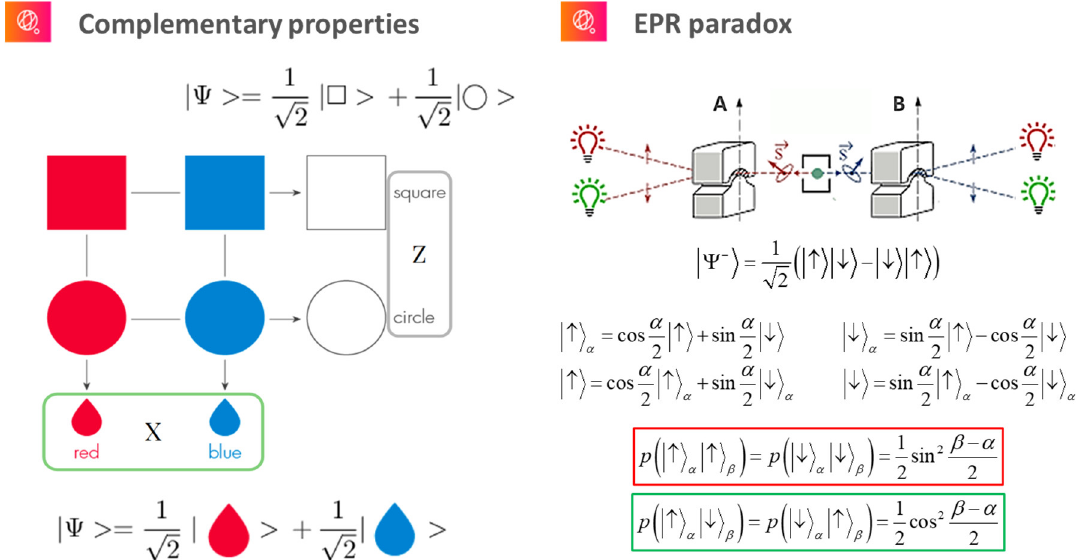
Figure A5. Examples from the specific path “Fundamentals: Realism and locality”. Left panel: pictorial representation of complementary properties. Right panel: scheme of the EPR paradox experiment and mathematical description of the entangled state and the values of detection probabilities for complementary measurements.